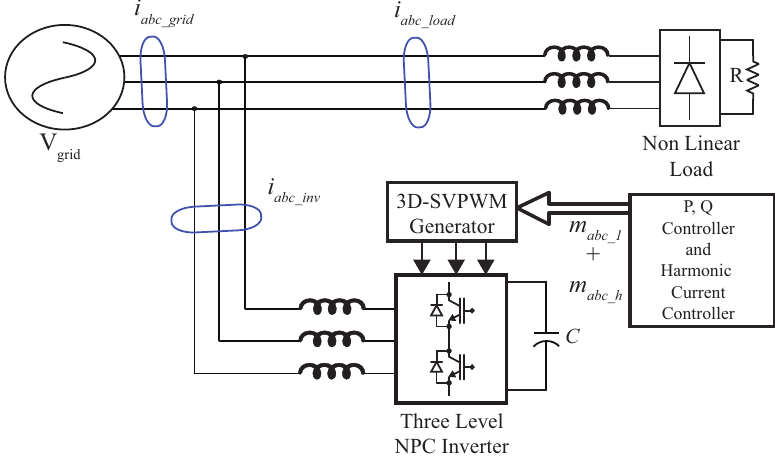
Figure 1. Active power filter with multilevel inverter